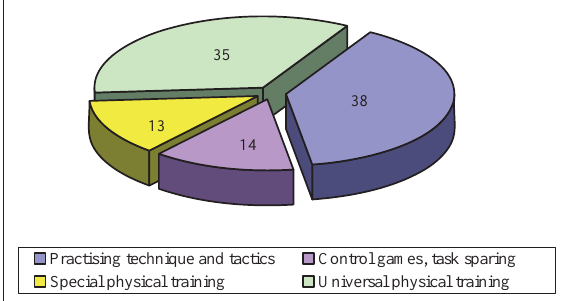
Fig. 2. Proportions of training means in the restoration phase, %